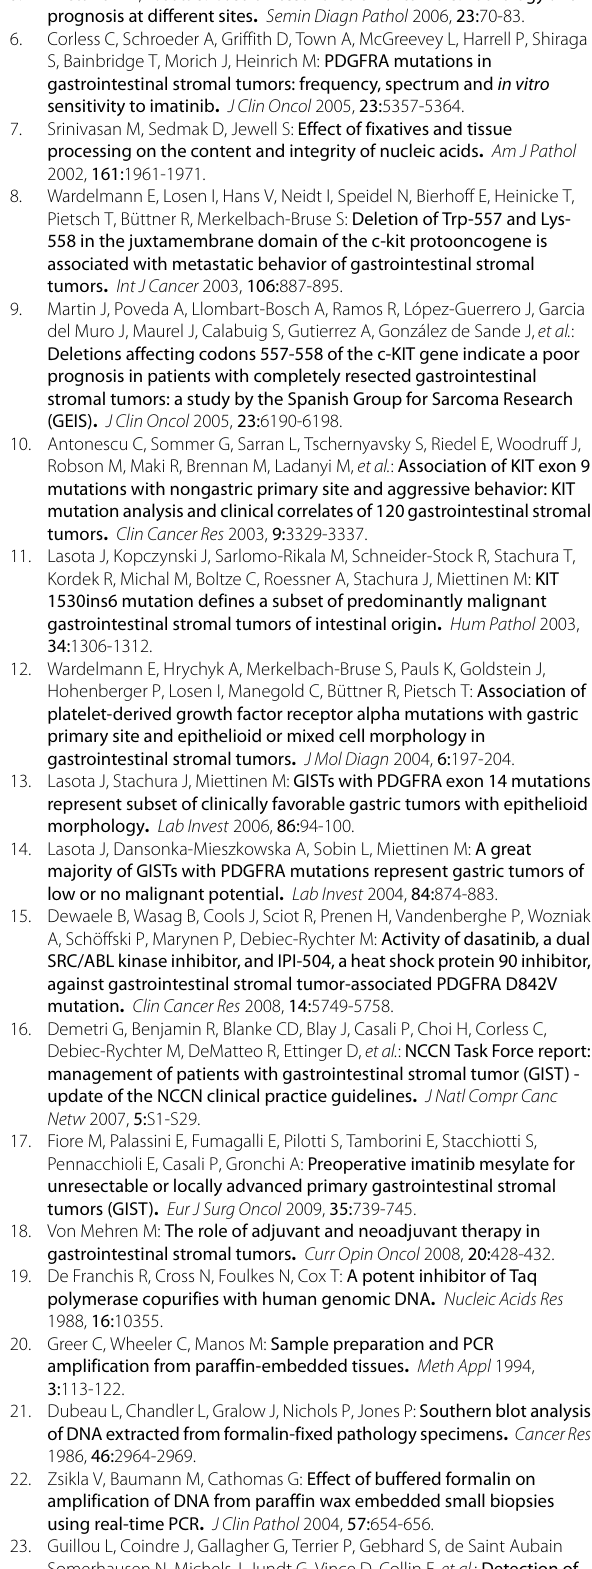
Additional file 4 Tables AF1-4 . The four tables contain technical details about DNA extraction, primer sets, conditions for PCR ampiflications, purifi- cation of PDR products and conditions for cycle sequencing. Table AF 1. Kits used for DNA extraction. Table AF 2. Primersets and conditions for PCR amplification of KIT exon 9 and 11 and PDGFRA exon 18. Table AF 3. Purifica- tion of PCR products prior to cycle sequencing. Table AF 4. Kits, devices and conditions used for cycle